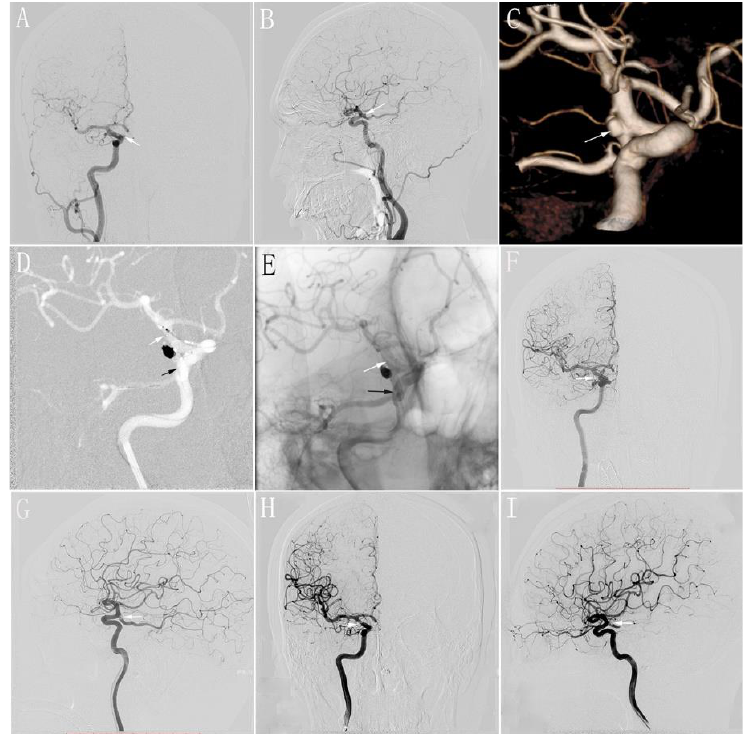
Figure 3. ( A , B ): Preoperative anteroposterior ( A ) and lateral ( B ) DSA of the R-ICA showing a wide- necked aneurysm that is located in the origin of the PCoA (white arrow); ( C ): Preoperative three- dimensional reconstruction of the R-ICA showing a wide-necked aneurysm (white arrow); ( D ): The stent is completely released by the swinging-tail technique. The distal segment of the stent is located in the PCoA (black arrow) and the proximal segment of the stent is located in the distal segment of the R-ICA at the ostium of the PCoA (white arrow); ( E ): Postoperative immediate unsubtracted DSA showing the location of stent (black arrow: the distal segment of the stent; white arrow: the proximal segment of the stent); ( F , G ): Postoperative immediate anteroposterior ( F ) and lateral ( G ) DSA of the R-ICA showing complete occlusion of the aneurysm (white arrow); ( H , I ): Anteroposterior ( F ) and lateral ( G ) DSA at 6 months of follow-up postoperatively of the R-ICA showing complete occlusion of the aneurysm (white arrow). DSA: digital subtraction angiography; PCoA: posterior communicating artery; ICA: internal carotid artery.